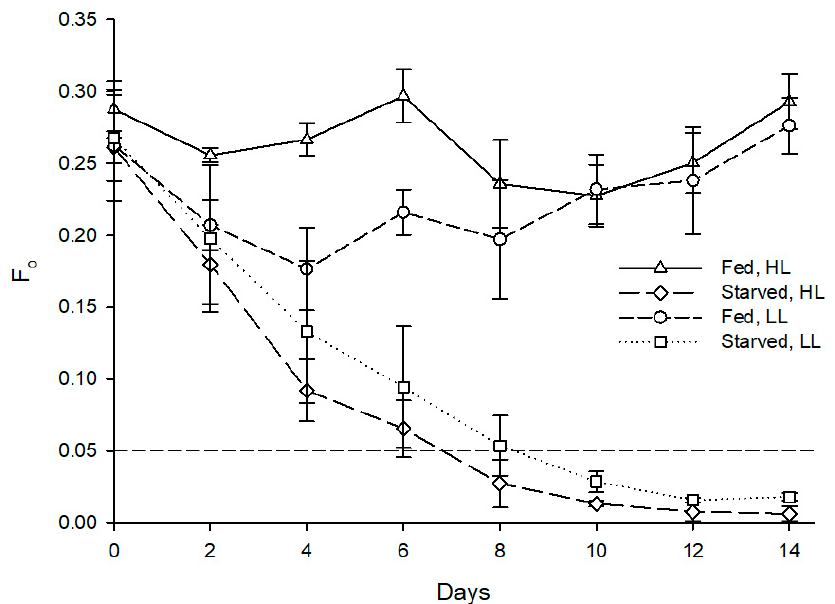
Figure 4. Evolution of fluorescence parameter F o in photosynthetic dinoflagellate endosymbionts hosted by Berghia stephanieae reared under different light intensities and diets (mean ± std. error, starting n = 5). HL—high light (80 µ mol photon m − 2 s − 1 ), LL—low light (10 µ mol photon m − 2 s − 1 ). The dashed line indicates the threshold of F o corresponding to the absence of endosymbionts detectable in sea slugs’ cerata using